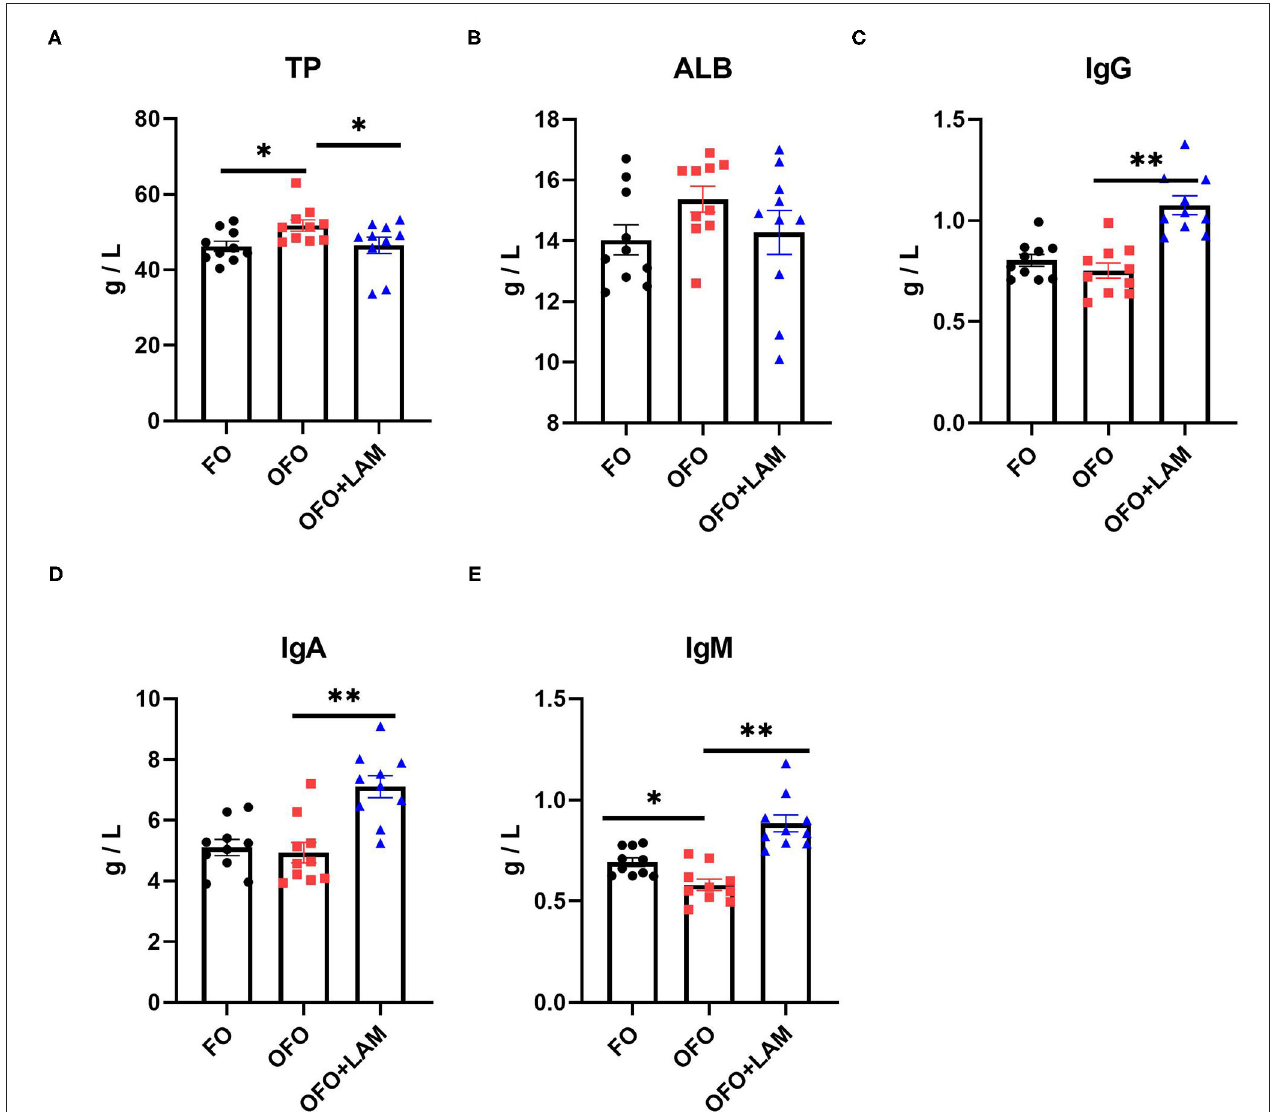
FIGURE 1 | The effect of fish oil (FO), oxidized fish oil (OFO), and OFO with lipoamide (LAM) on serum biochemical and immunological indicators. (A) Content of total protein (TP) in FO, OFO, and OFO + LAM. (B) Content of albumin (ALB) in FO, OFO, and OFO + LAM. (C) Content of immunoglobulin A (IgA) in FO, OFO, and OFO + LAM. (D) Content of immunoglobulin G (IgG) in FO, OFO, and OFO + LAM. (E) Content of immunoglobulin M (IgM) in FO, OFO, and OFO + LAM. ** p < 0.01 and * p < 0.05 indicate significant differences between two